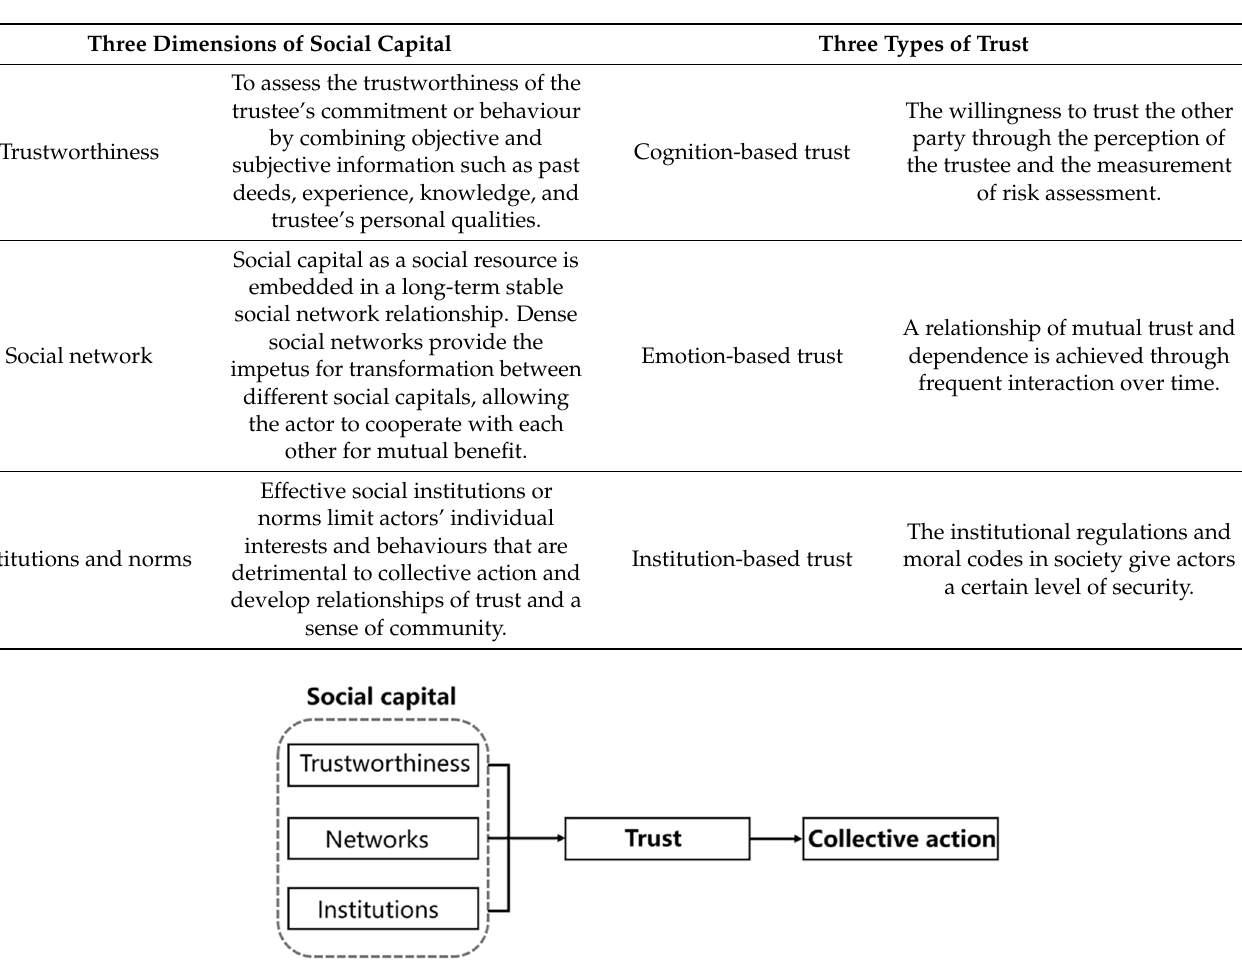
Table 1. Correlation table between social capital and trust.